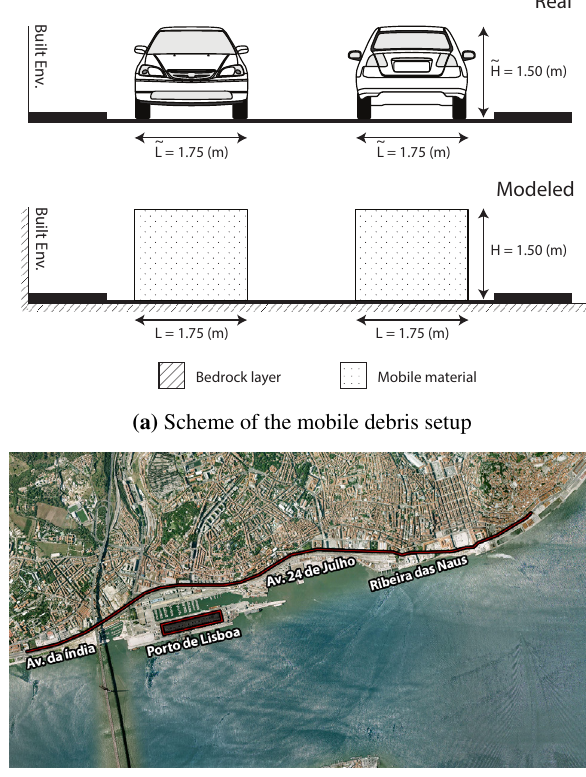
Fig. 12. Mobile debris setup along Lisbon’s Fig. 12: Mobile debris setup along Lisbon’s riverfront Fig. 12: Mobile debris setup along Lisbon’s riverfront